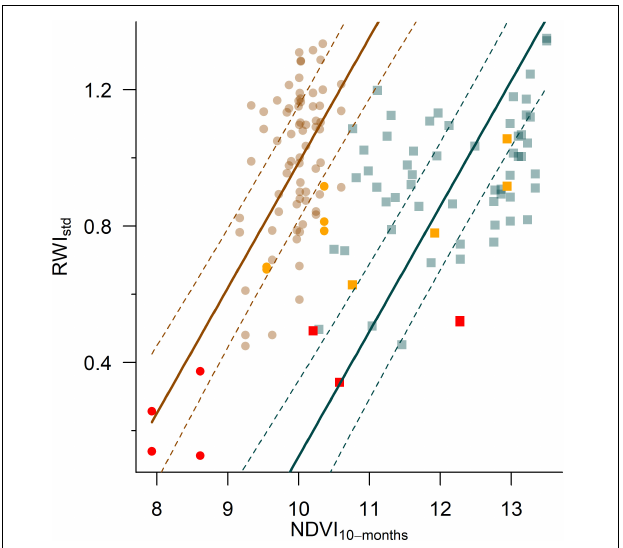
FIGURE 4 | Temporal trends in within-group tree-ring width (RWIres) synchrony calculated for dry (red symbols and areas) and wet (blue symbols and areas) sites. The synchrony was calculated for the best model considering 20-year moving intervals lagged by 1 year over the period 1983–2016. The x -axis shows the central year of the moving intervals. Lines and points represent observed values and shadows are standard errors. Synchrony increased sharply between the second and the third periods (1985–2005 and 1986–2006), and was higher in dry sites than in wet sites during the following periods. The results correspond to a homocedastic variance covariance (VCOV) unstructured model.